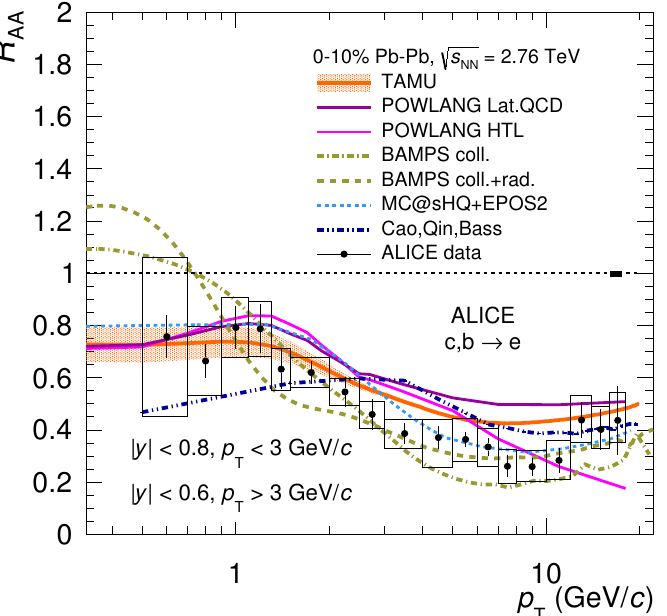
Figure 4 . R AA of electrons from semileptonic heavy-(cid:13)avour hadron decays at mid-rapidity as a function of p T in 0{10% Pb{Pb collisions at tions [80{85].